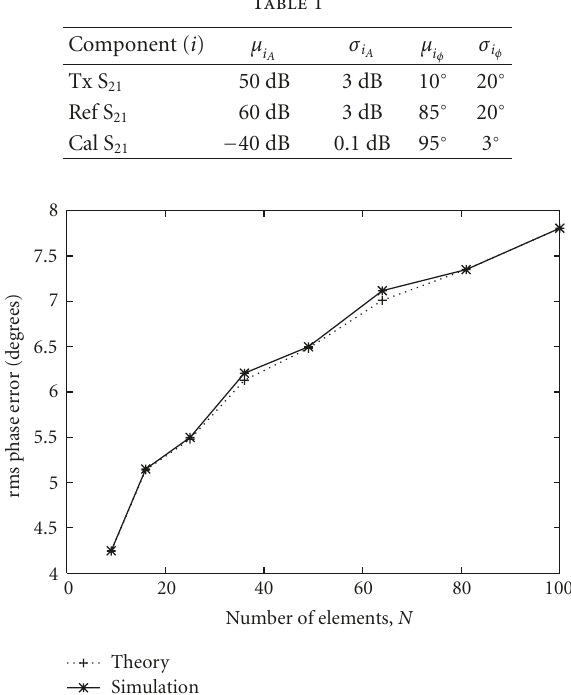
Figure 9: The overall array calibration accuracy predicted by (4) and the calibration simulation for σ c